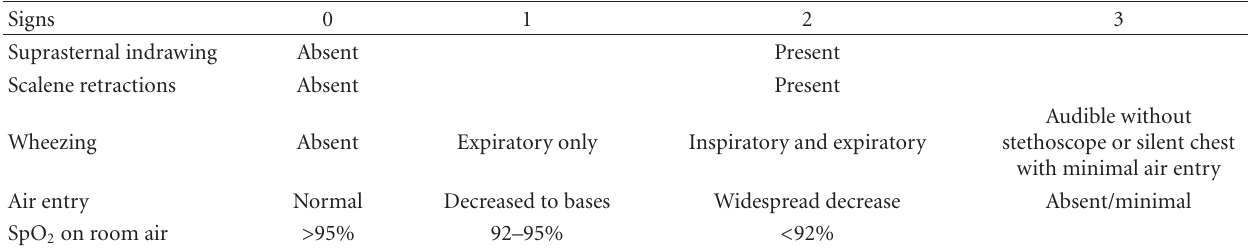
Table 2: The Pediatric Respiratory Assessment Measure (PRAM). Scores of 0–4 indicate mild disease, 5–8: moderate disease, 9–12: severe disease. SpO 2 : Oxygen Saturation.